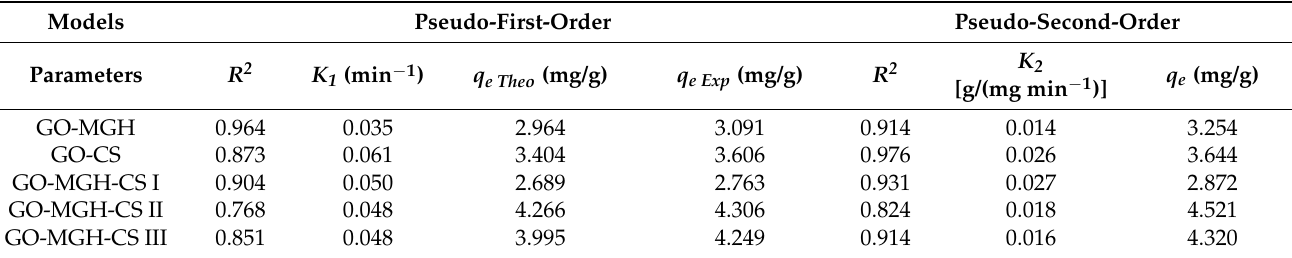
Figure 7. Fitting the pseudo-first-order kinetic model ( a ) and the pseudo-second-order kinetic model ( b ) to the experimental values. Table 4. The parameters of the kinetic models for